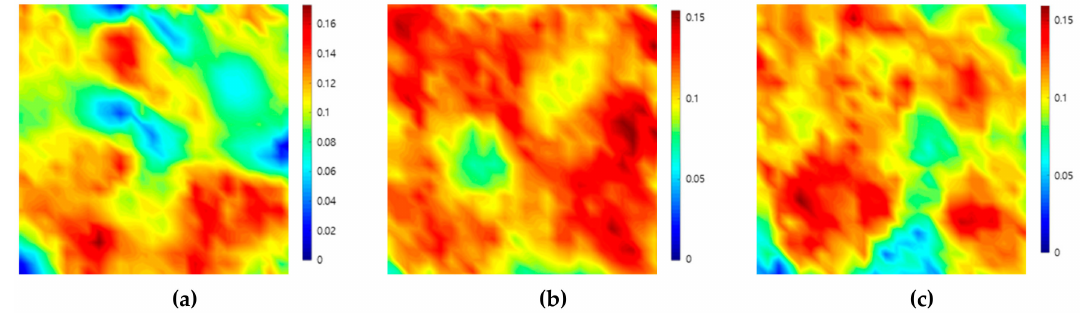
Figure 6. Ultrasonic attenuation map from the ( a ) top, ( b ) front, and ( c ) side scanning of a weld-metal specimen using attenuation coe ffi cient values and the ultrasonic pulse-echo method.